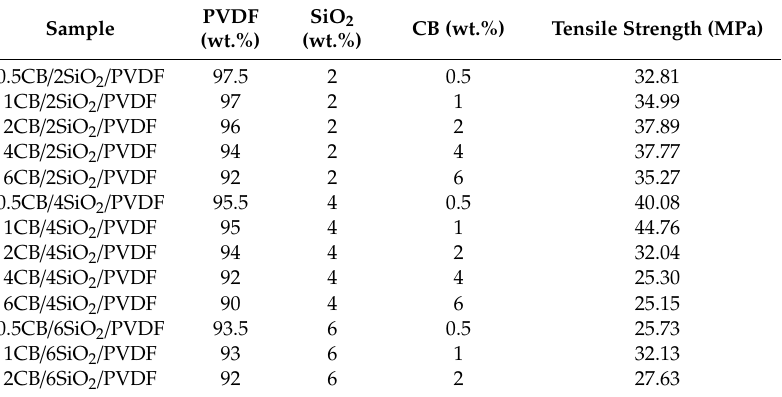
Table 3. Information of the